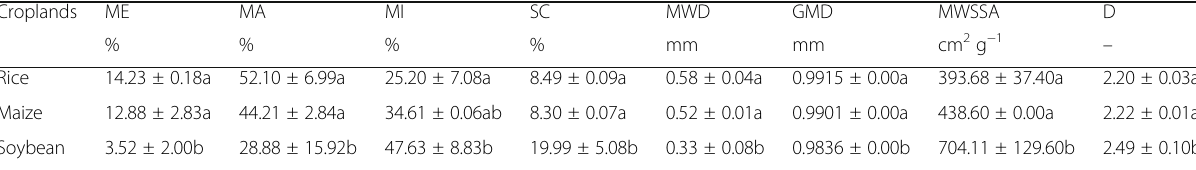
Table 1 Changes in proportion and parameters related to soil aggregates under different croplands